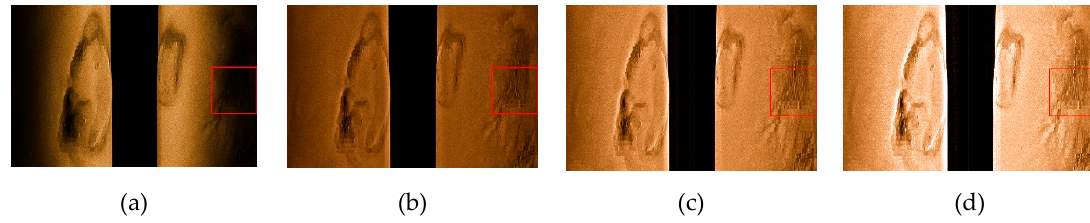
Figure 4. Experimental comparison using mean filter. ( a ) Original image and corrected image with ( b ) A = 80, ( c ) A = 140, and ( d ) A = 200.